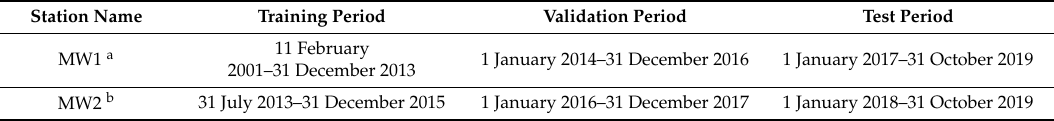
Table 2. Training, validation, and test periods for LSTM modeling.